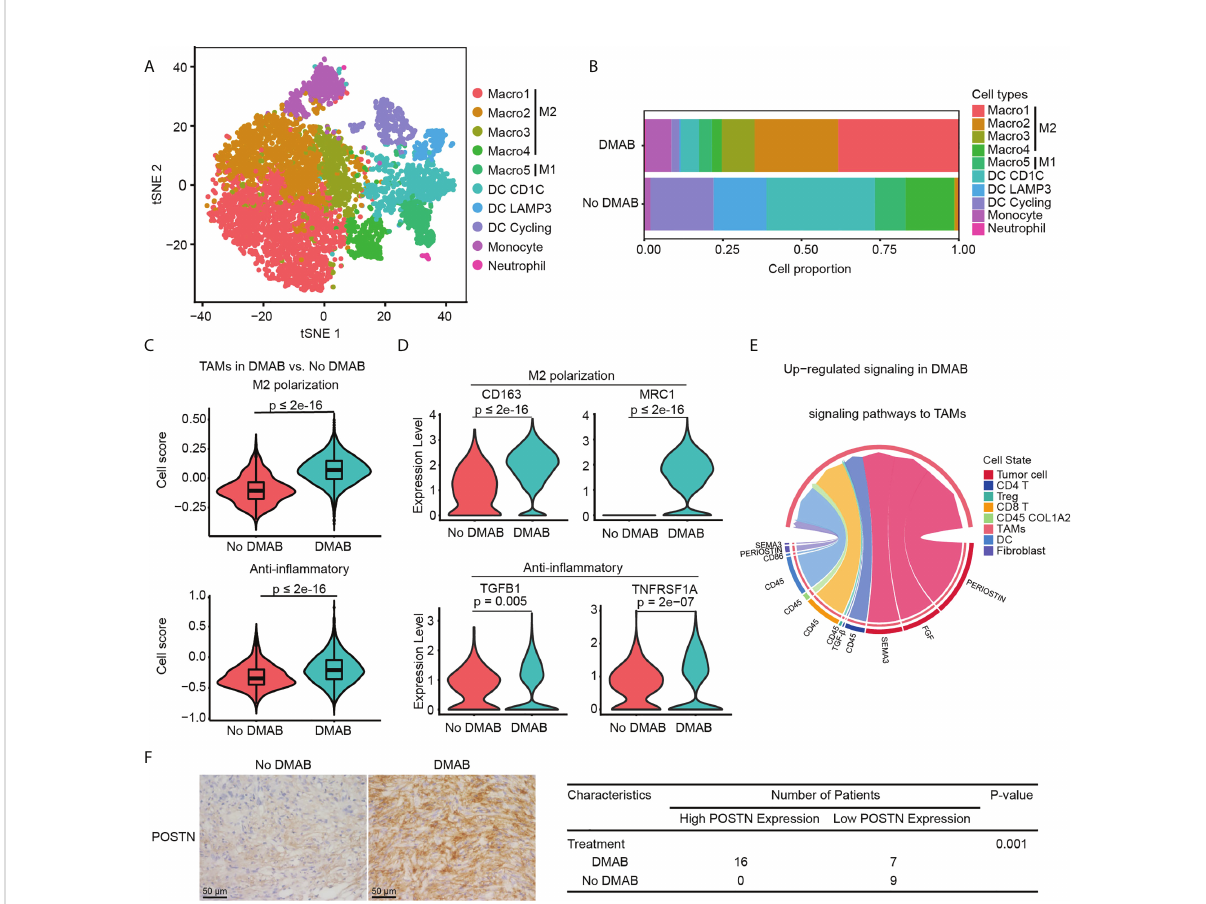
FIGURE 4 DMAB treatment promotes the M2 subtype of TAMs via periostin (POSTN). (A) t-SNE plot showing the subtypes of myeloid-derived cells derived from No DMAB and DMAB-treated GCTB patients. (B) Histogram showing the proportion of myeloid subgroups in No DMAB and DMAB-treated samples. (C) Violin plot showing the M2 polarization and anti-in fl ammatory scores of TAMs from the No DMAB (red) and DMAB-treated (blue) samples. The p values were calculated using a Student ’ s t test. (D) Violin plot showing the expression levels of selected M2 polarization and anti- in fl ammatory genes in TAMs from the No DMAB (red) and DMAB-treated (blue) samples. The p values were calculated using a Student ’ s t test. (E) Chord diagram showing the signi fi cantly upregulated signaling pathways in TAMs in GCTB after DMAB treatment. (F) Representative IHC images of POSTN in GCTB without DMAB (n =9) versus GCTB with DMAB (n = 23). Scale bar, 50 m m. Statistical table of 32 GCTB samples by POSTN staining intensity. Signi fi cance was determined by a fi sher exact